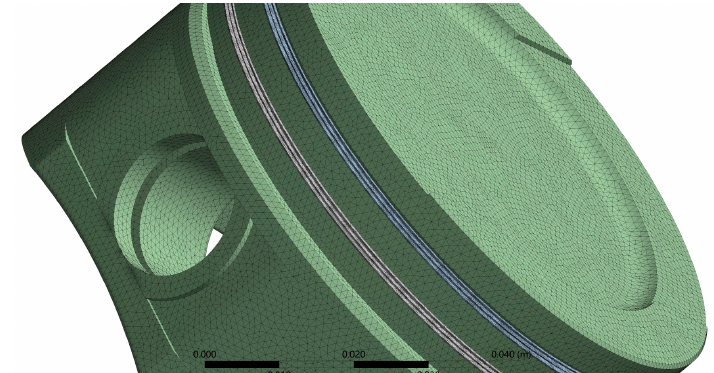
Figure 3. Mesh divided after piston and piston ring